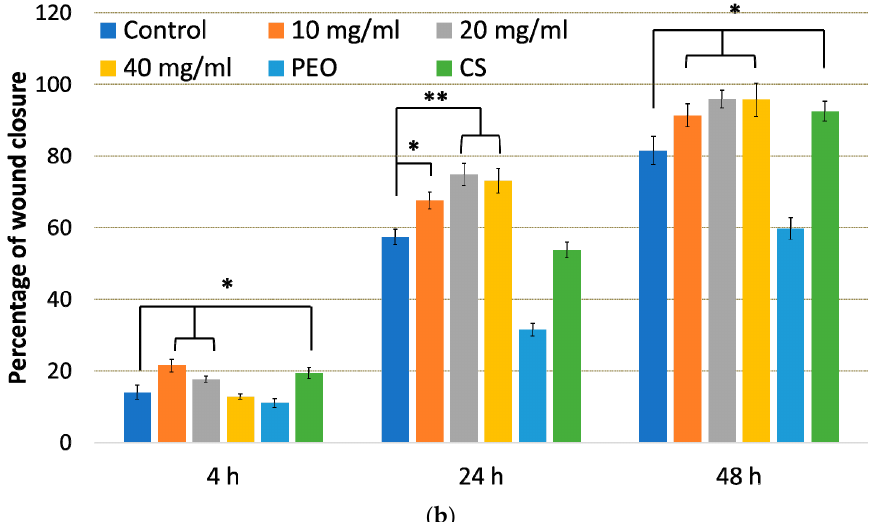
Figure 9. ( a ) Representative scratch assay images and ( b ) percentage of wound closure over 48 h period representing cellular migration and proliferation of control cells, cells in the presence of: nanofiber CS/PEO 10% extract at concentrations 10, 20 and 40 mg/mL, pure PEO, or pure CS as controls. * represents significant differences with p ≤ 0.05, while ** with p ≤ 0.01 in comparison to untreated cells.